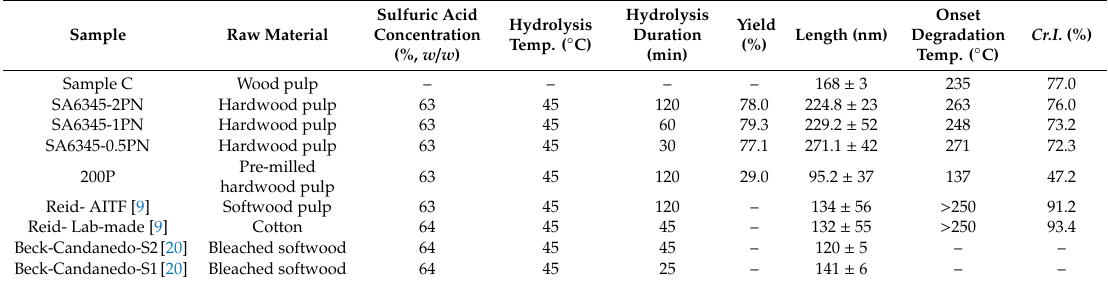
Table 2. E ff ect of hydrolysis conditions on the resulting CNC